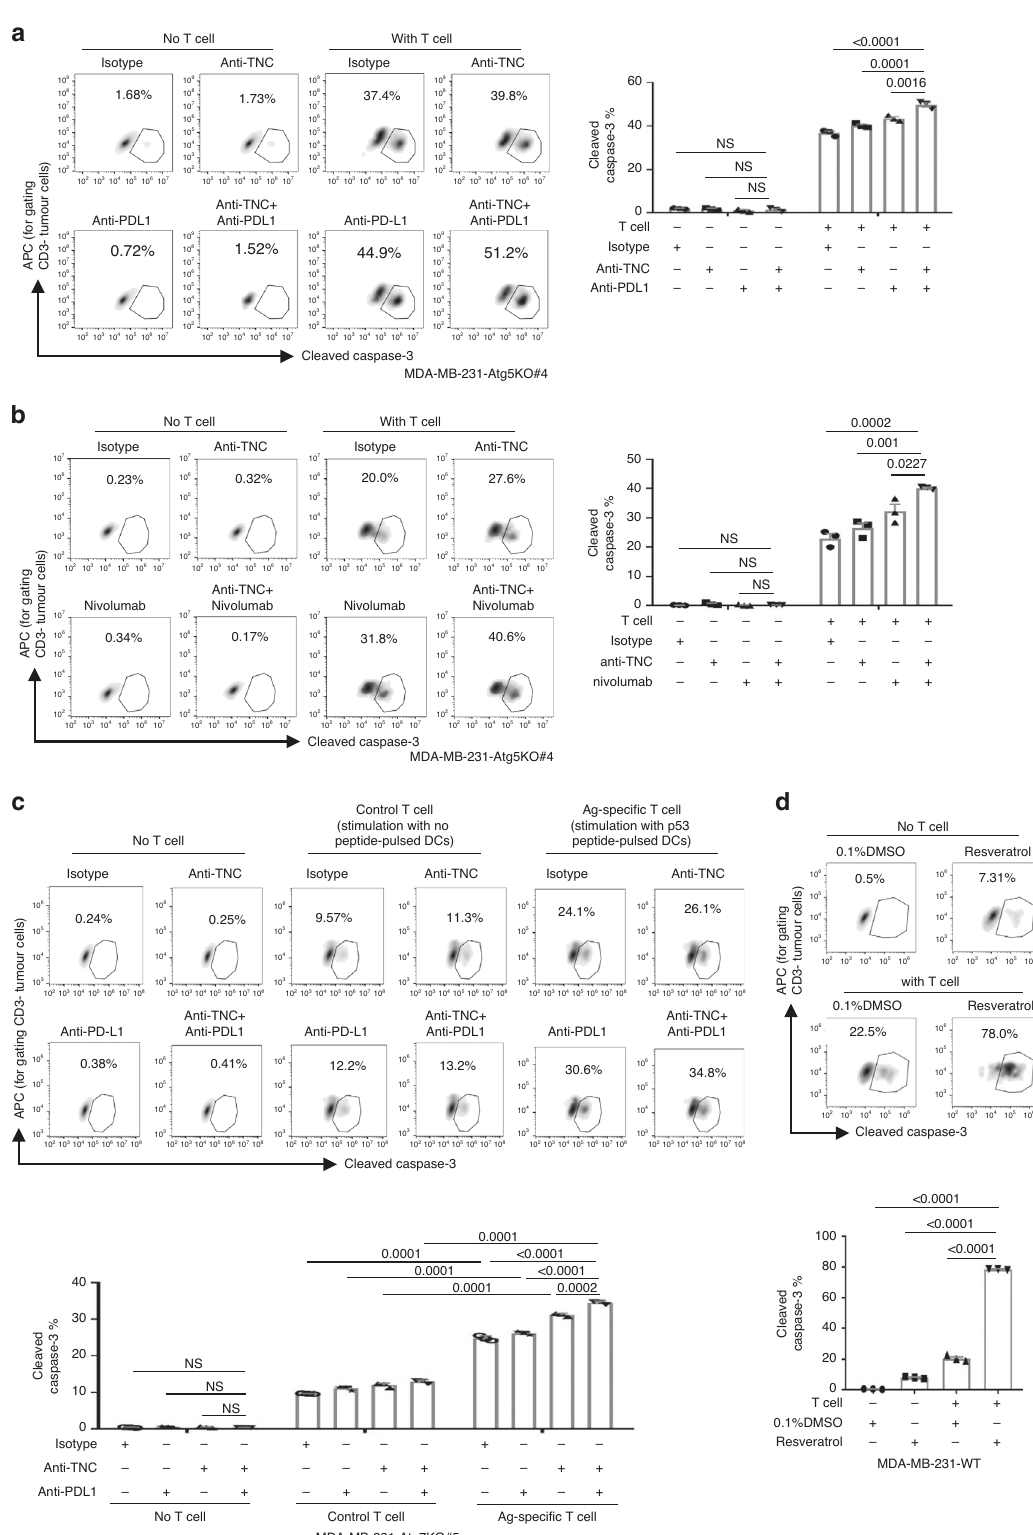
medium supplemented with 10% FBS at 37 °C under 5% CO 2 . All the cells were Bioscience), Resveratrol (R5010, Sigma), and Recombinant Murine IFN- γ authenticated using short-tandem repeat pro fi ling, and tested negative for myco- (Cat#315-05, Peprotech) were obtained commercially. plasma contamination. Hypoxic conditions were achieved with a hypoxic chamber fl ushed with a pre-analyzed gas mixture of 1% O 2 , 5% CO 2 , and 94% N 2 . EBSS (#14155-063) was obtained from Thermo Fisher Scienti fi c. Compounds MG132 Plasmids . Human full-length p62, NDP52, NBR1, TAX1BP1, Tollip, Optn and (S2619), ba fi lomycin A1 (S1413) and rapamycin (S1039) were obtained from BNIP3L cDNA (with fused C-terminal FLAG tag) was subcloned into pcDNA3.1 Selleck Chemical. CHX (BS168A, Biosharp), BMS 303141 (#4609, Tocris vector (Invitrogen). Human full-length Atg5 cDNA and Atg7 cDNA